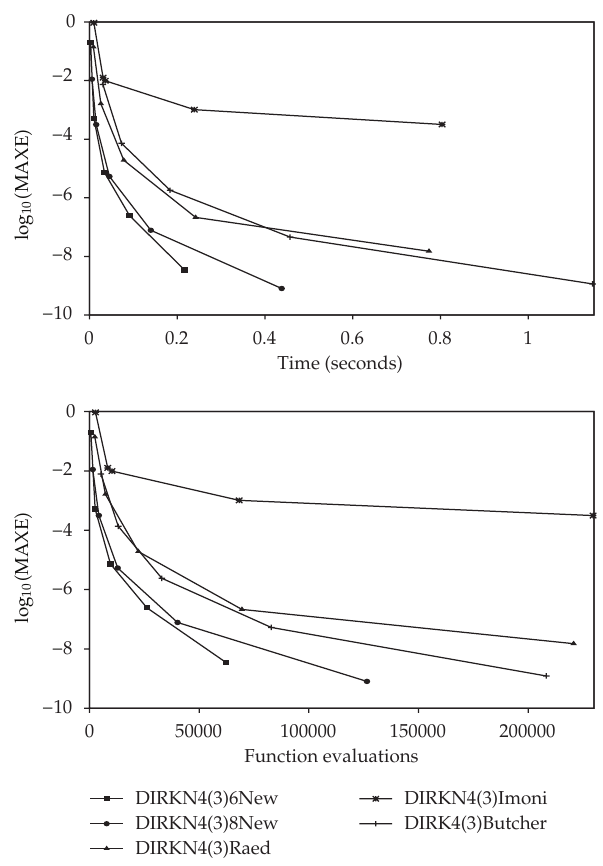
Figure 4: E ffi ciency curves for Problem